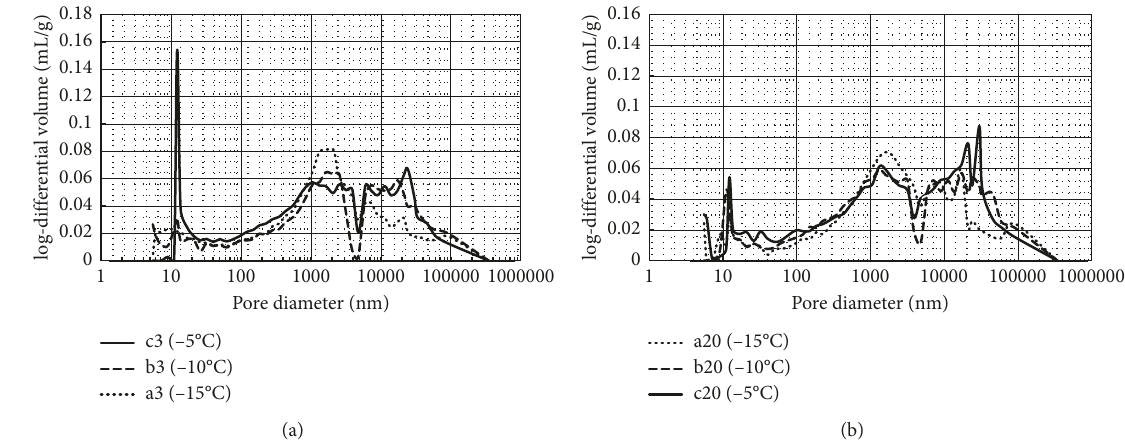
Figure 4: Distribution curves of logarithmic differentiation of soil pore diameters after 3 (a) and 20 (b) freeze-thaw